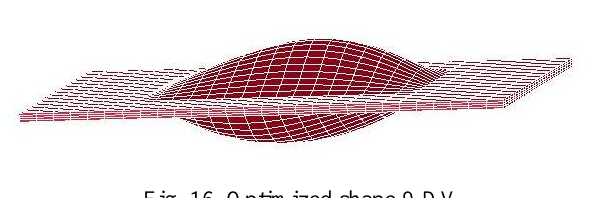
Fig. 16. Optimized shape